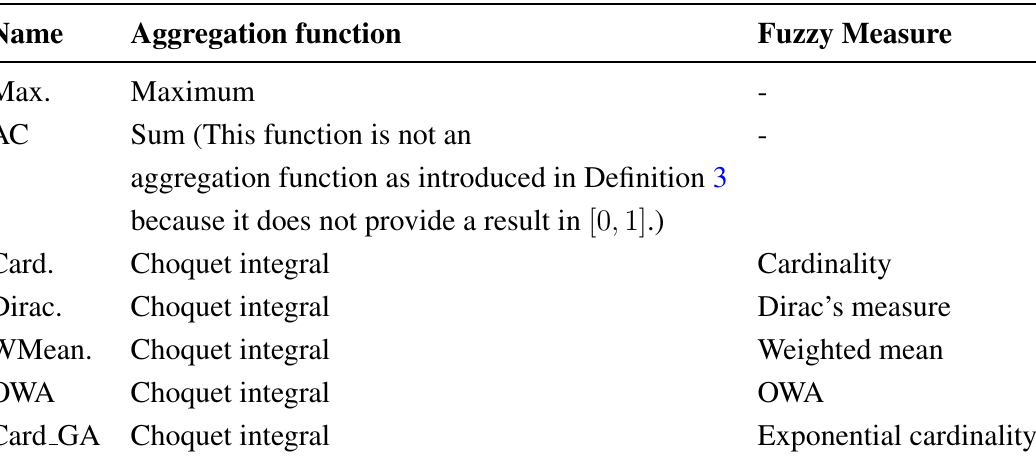
Table 2. Names given to the seven approaches used in the